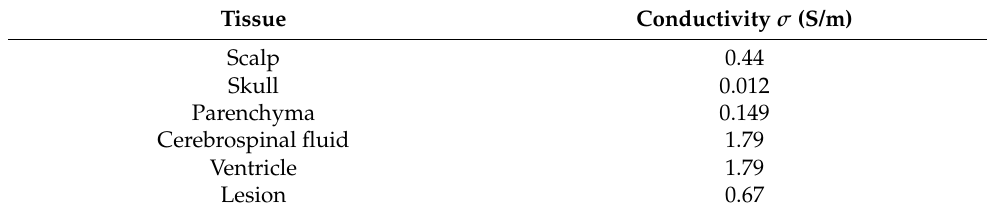
Table 1. Conductivity setting of different tissue.